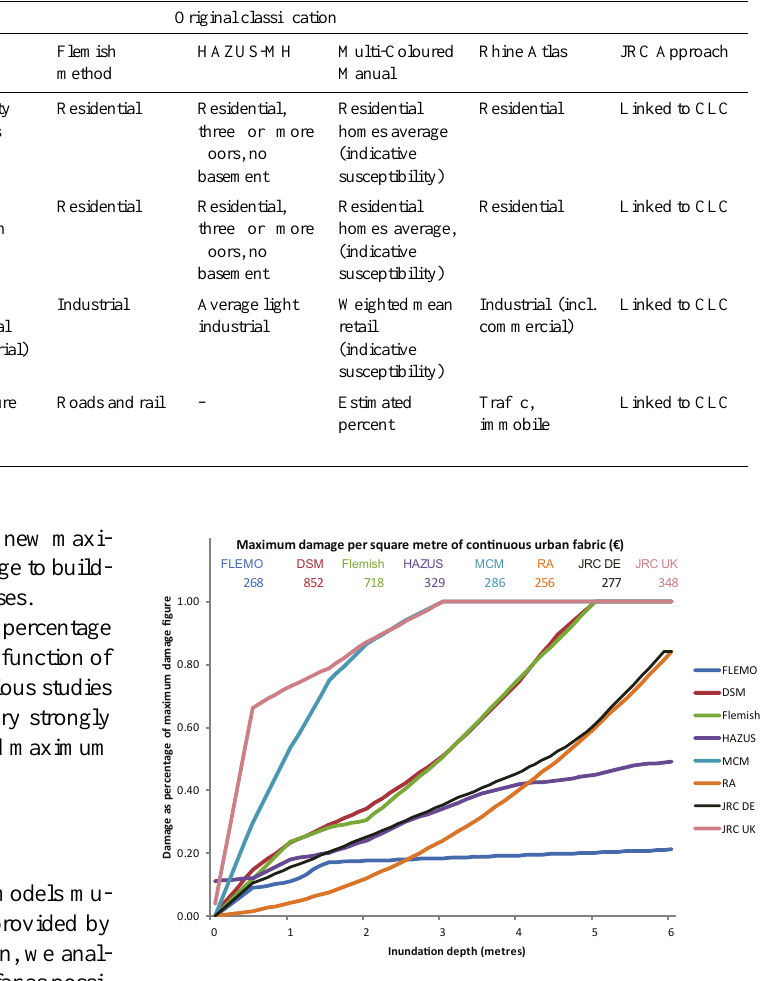
Fig. 6. Depth–damage functions and corresponding maximum dam- age figures for the CORINE land use class “continuous urban fab- ric”. The functions of each damage model are based on a manual selection of available damage classes, except for the JRC Model which is designed to match CORINE land use data (Table 1; Sect.